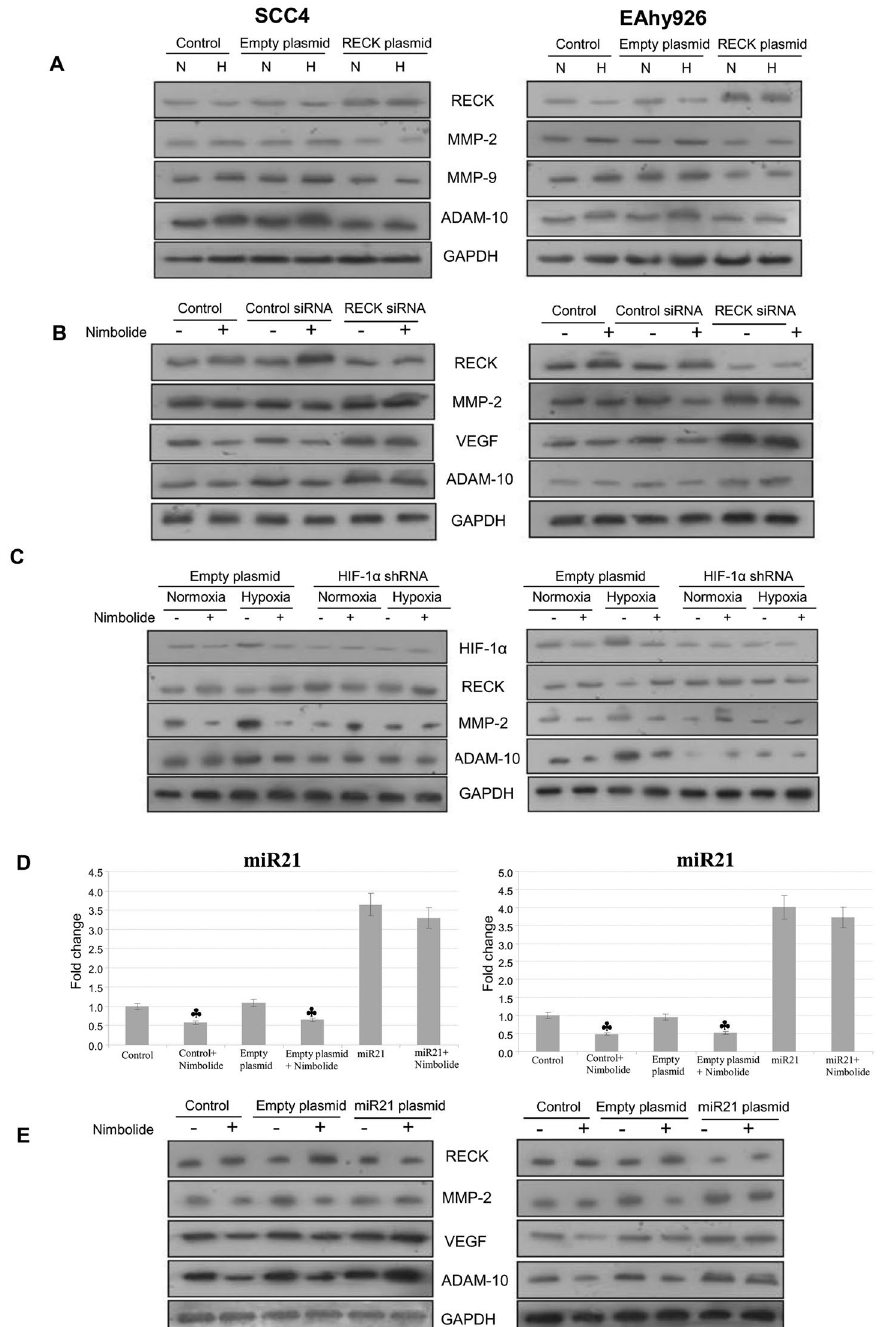
Figure 7. Nimbolide activates RECK by targeting HIF-1 α and miR-21. ( A ) Immunoblot analyses of RECK, MMP-2, MMP-9 and ADAM-10 in control, empty plasmid and RECK plasmid transfected SCC4 and EAhy926 cells under normoxic and hypoxic conditions (N = 3). ( B ) Immunoblot analyses of RECK, MMP-2, VEGF and ADAM-10 in control, Control siRNA and RECK siRNA transfected cells in the absence or presence of nimbolide (1 µ m). ( C ) Immunoblotting was performed to analyse the expression of HIF-1 α , RECK, MMP-2 and ADAM-10 in empty vector and HIF-1 α RNAi transfected cells under normoxic and hypoxic conditions in the presence or absence of nimbolide (1 µ m). ( D ) Transcript expression level of miR-21 in control, empty plasmid and miR-21 plasmid in the presence or absence of nimbolide (1 µ m) in SCC4 and EAhy926 cells as determined by quantitative RT-PCR. ♣ p < 0.001 versus normoxia. * p < 0.001versus hypoxia. ( E ) Immunoblotting was performed to analyse the expression of RECK, MMP-2, VEGF and ADAM-10 in control, empty plasmid and miR-21 plasmid in the presence or absence of nimbolide (1 µ m) in SCC4 and